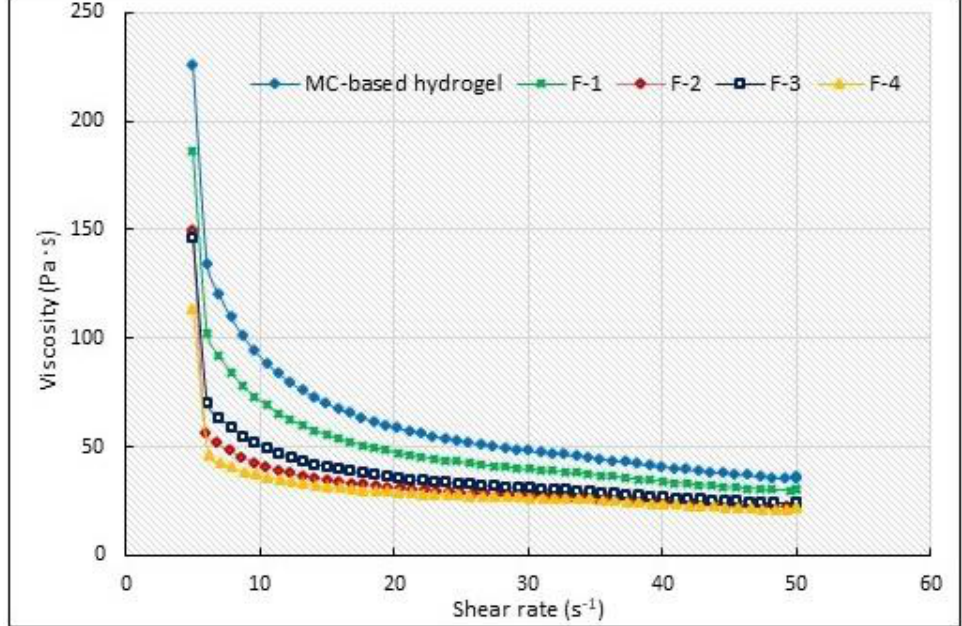
Figure 3. Viscosity curves for formulations containing STH at concentration 0.1% — F-1 and STH with addition of ALB: F-2 at concentration STH:ALB 0.1%:0.1%, F-3 at concentration STH:ALB 0.1%:0.2%), F-4 at concentration STH:ALB 0.1%:0.5% and unloaded hydrogel base, containing MC ( n =